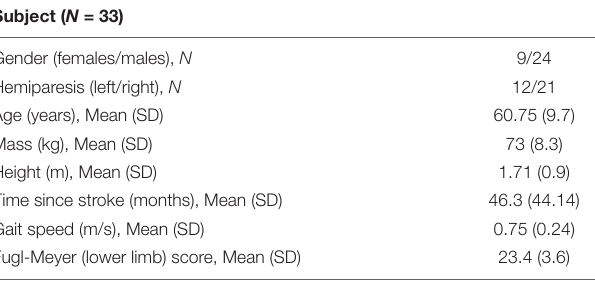
TABLE 1 | Characteristics of the study